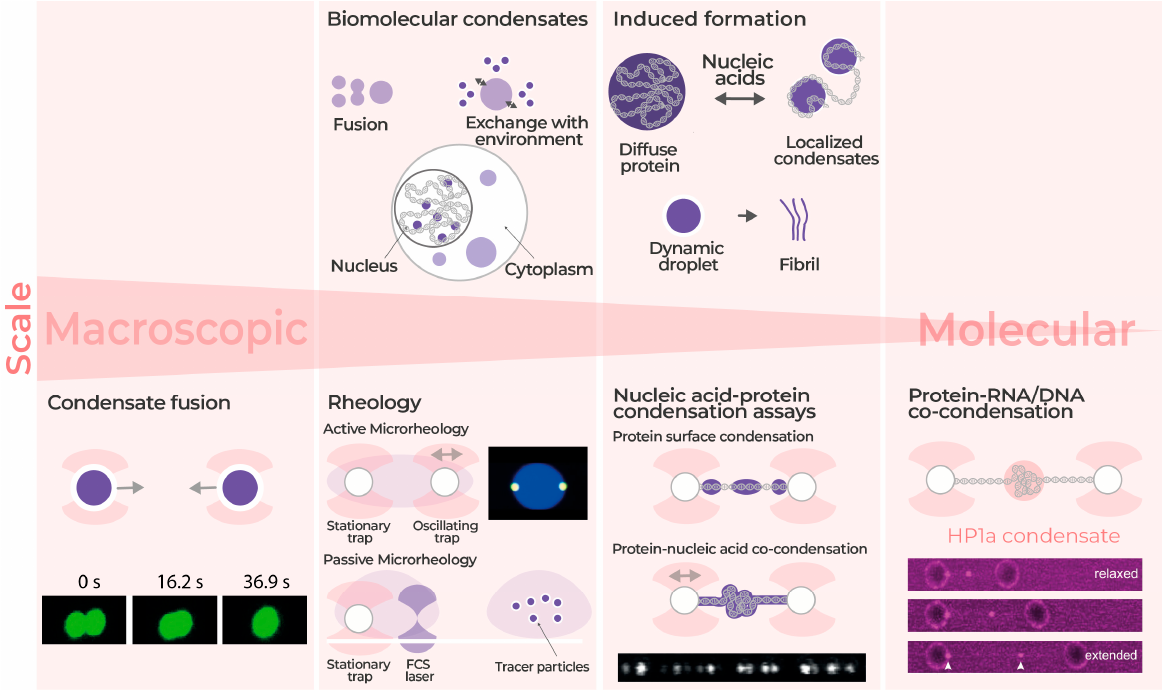
Figure 4. Phase Separation: Top row: An overview of biomolecule condensates, their structure, and the aging process. Bottom row, from left to right: Condensate fusion: how the fusion of biomolecule condensates is facilitated by trapping condensates directly in optical traps. An example of condensate fusion is depicted at the bottom left, where fusion speed is measured by observing the process in real-time. Rheology: Schematic diagram of active and passive rheology using two and one optically trapped beads inside the condensate, respectively. Schematic of single-molecule nucleic acid-protein condensation assays that can result in surface condensation or co-condensation. Surface condensation: The confocal image is from a study in which an optical tweezer set-up was employed to directly observe the condensation of Klf4-GFP on a DNA molecule tethered between two trapped beads. This study shows that the surface condensations on the DNA molecule form through a switch-like transition. Co-condensation: An example of the co-condensation of protein-RNA/DNA. Fluorescence confocal images were taken when the tethered DNA was in a relaxed (low force), intermediate, and extended (high force) state. This study showed these co-condensations resist high forces. The white arrowheads show HP1a-DNA condensates. Adapted with permission from [114] Copyright (2018) the American Physical Society, and open sources [74,132,133].